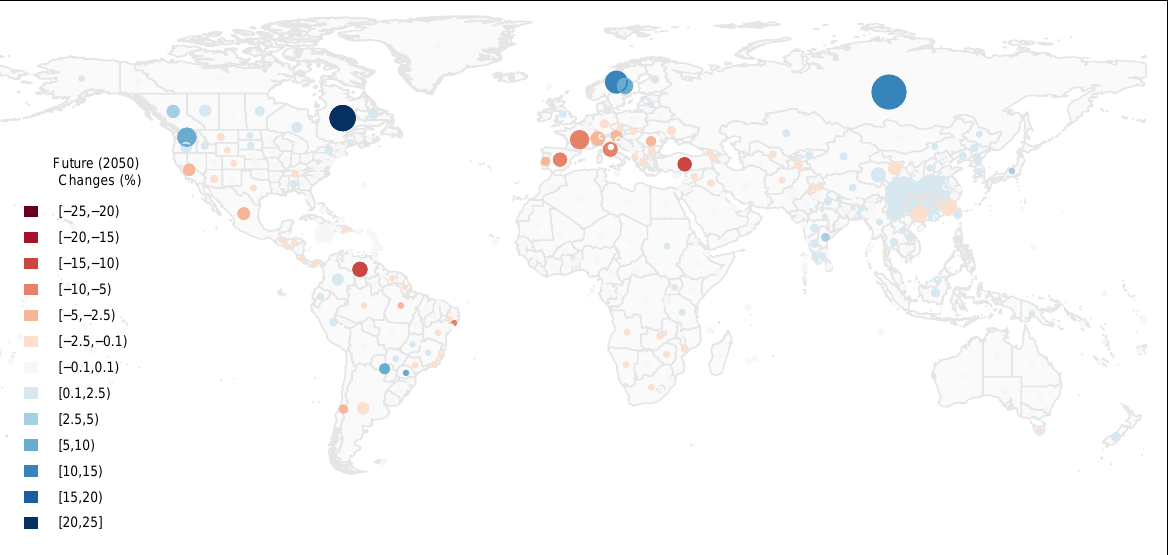
Table 5. Summary of Regional (2050) Changes in Hydropower generation. Continent Region